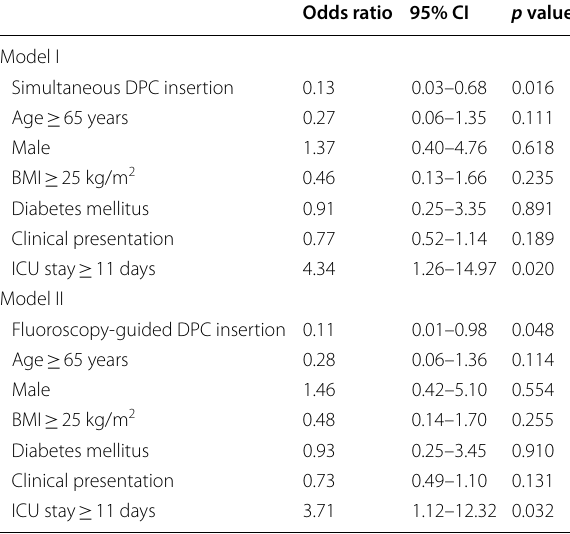
Table 3 Predictors of lower limb